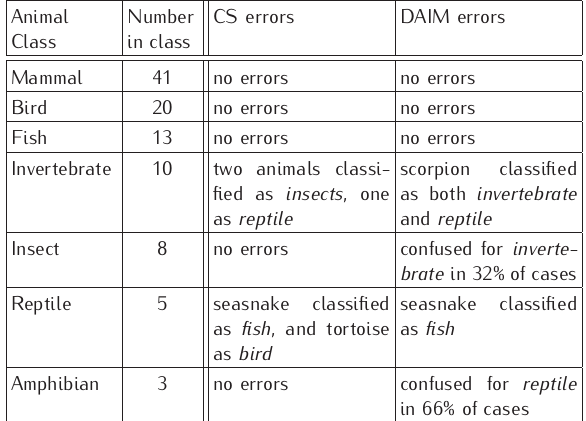
Table 2. Animal instances where CS and DAIM made classification errors, and how the errors are made: compare with Table 1 for overall correct classificationrate. ForDAIM,resultsof10-foldcross-validationshown.